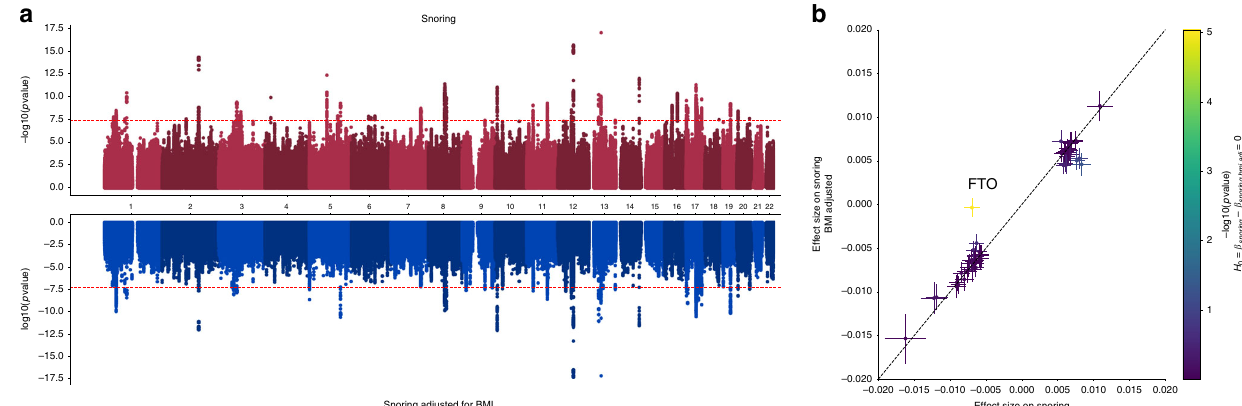
Fig. 2 Genetic variants associated with snoring with and without adjustment for BMI. a Results from the genome-wide association studies are presented as a Miami (mirrored Manhattan) plot. The x -axis contains a point for each genetic variant passing QC and is ordered by chromosome and base position. The distance between each variant and the x -axis is a function of the signi fi cance ( p -value) of the association. For the top panel the − log10( p -value) is graphed on the y -axis, whereas the log10( p -value) is shown for the bottom panel (BOLT-LMM mixed model association test p -value). The red dotted line denotes the genome-wide signi fi cance threshold ( p < 5e − 8). b Effect sizes of independent lead SNPs across snoring ( x -axis) and snoring adjusted for BMI ( y -axis). The only locus (FTO) with a statistically signi fi cant difference is